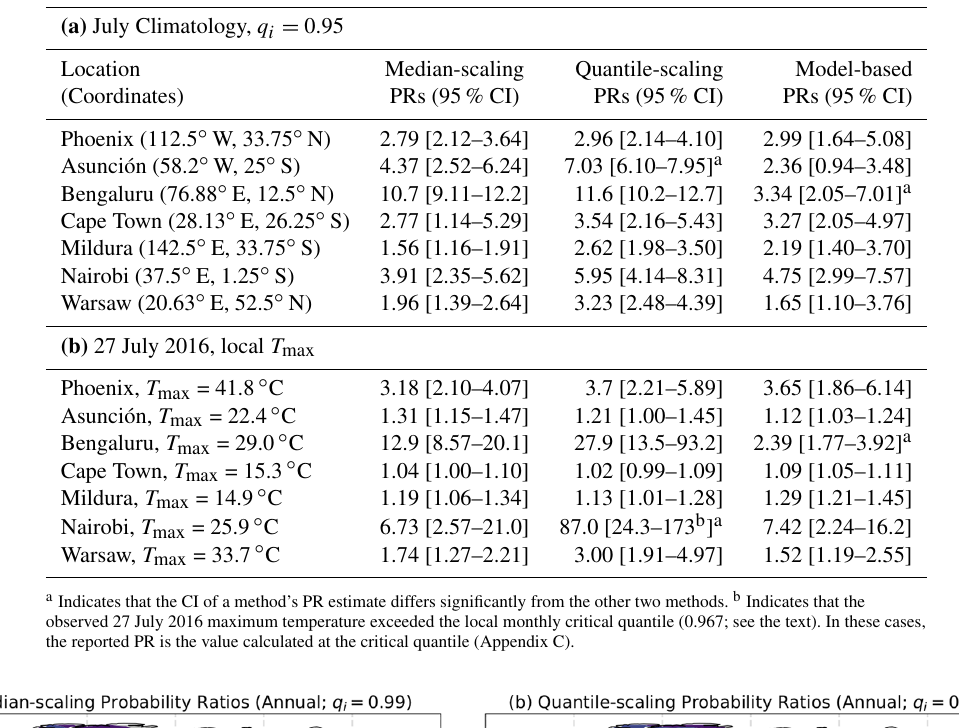
Table 1. Median and 95% confidence intervals (CI) of probability ratios (PRs) associated with (a) the local July monthly mean daily exceedances of the 95th percentile (calculated from the monthly counterfactual distribution; see the text) or (b) the local observed T max on 27 July 2016. Distributions with confidence intervals greater than PR = 1 are statistically significant. (a) July Climatology, q i = 0 . 95